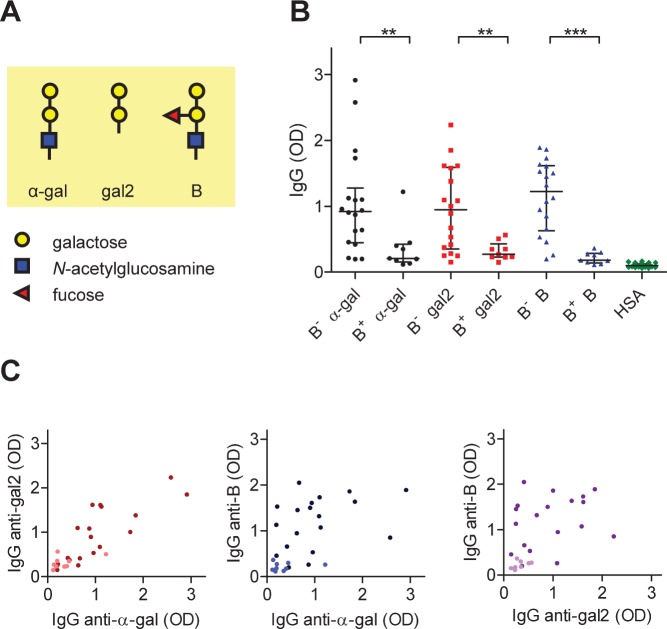
IgG responses to α-gal and blood group B antigens.A) Schematic representations of gal-α-1,3-gal-β-1,4-GlcNAc (α-gal), gal-α-1,3-gal (gal2) and blood group B (B) antigens. B) IgG anti-α-gal, anti-gal2, and anti-B in B+ and B– individuals, as measured in ELISA (1 µl serum/test). Bars represent median and interquartile ranges. B– individuals make significantly more IgG to all three antigens (Mann-Whitney; ** p<0.01; *** p<0.001). C) Correlations between IgG anti-α-gal and IgG anti-gal2 (Spearman r = 0.83; p<0.0001), IgG anti-α-gal and IgG anti-B (r = 0.59; p = 0.009), and IgG anti-gal2 and IgG anti-B (r = 0.58; p = 0.0011). Light-colored dots correspond to B+ subjects. None of the sera contained detectable amounts of IgE anti-α-gal.